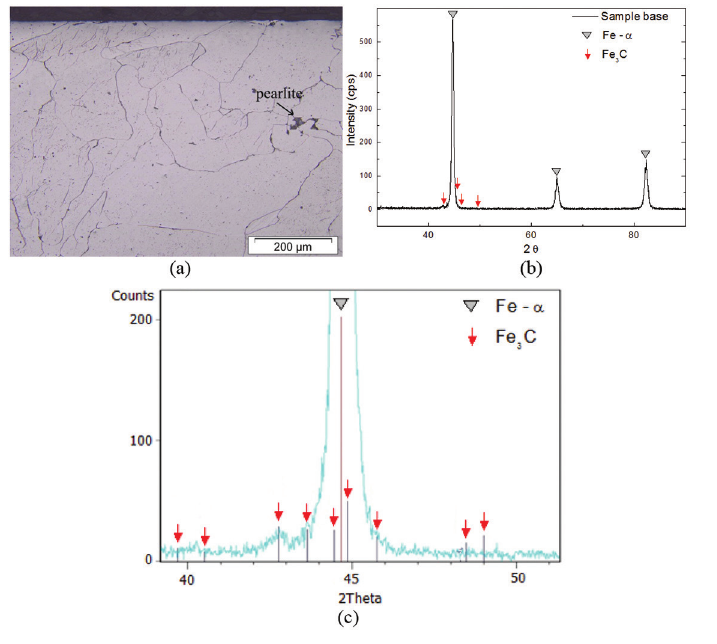
Figure 1: Sample base: (a) optical microscopy (b), XRD and (c) detailed XRD.